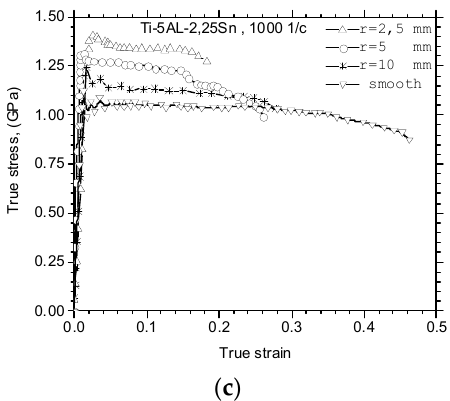
Figure 4. True stress versus true strain of Ti-5Al-2.5Sn specimens with notch radii of 10, 5, 2.5 mm at strain rates ( a ) 0.1 s − 1 , ( b ) 100 s − 1 , and ( c ) 1000 s − 1 .